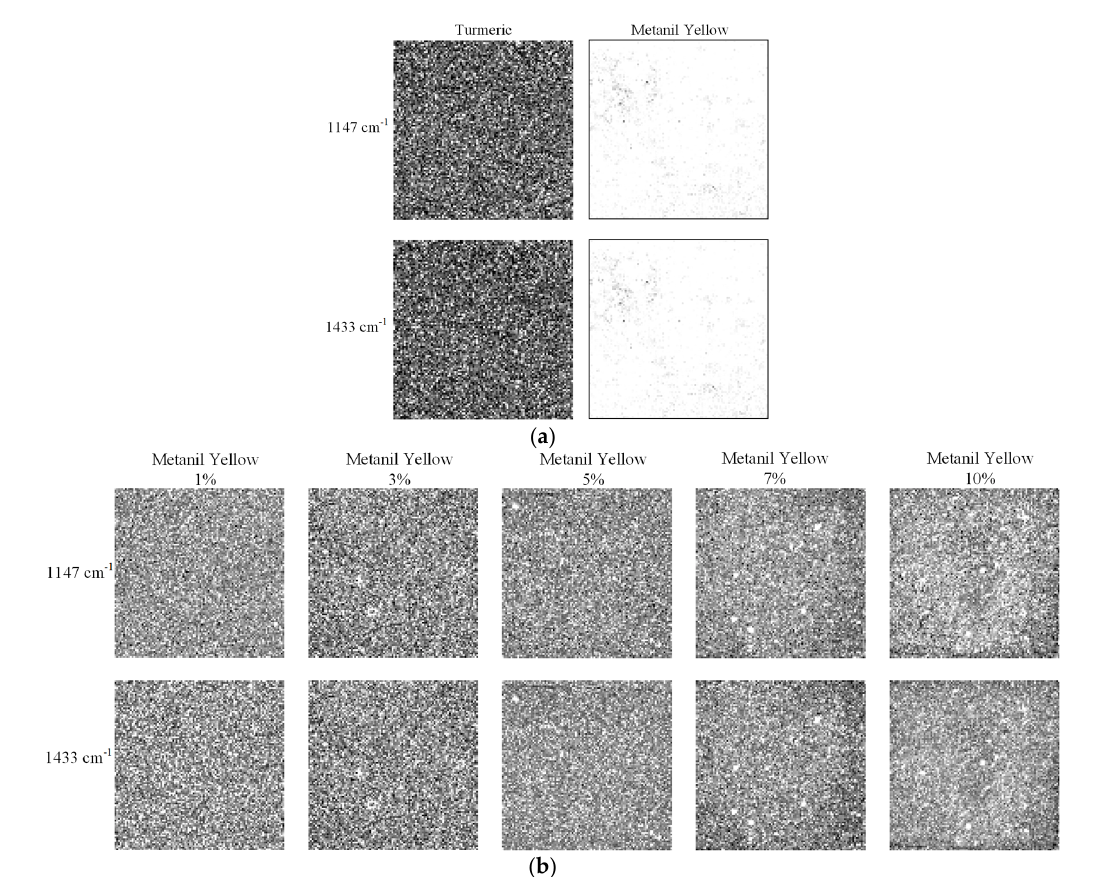
Figure 5. Raman spectral images of: turmeric and metanil yellow ( a ); turmeric-metanil yellow mixture samples ( b ).